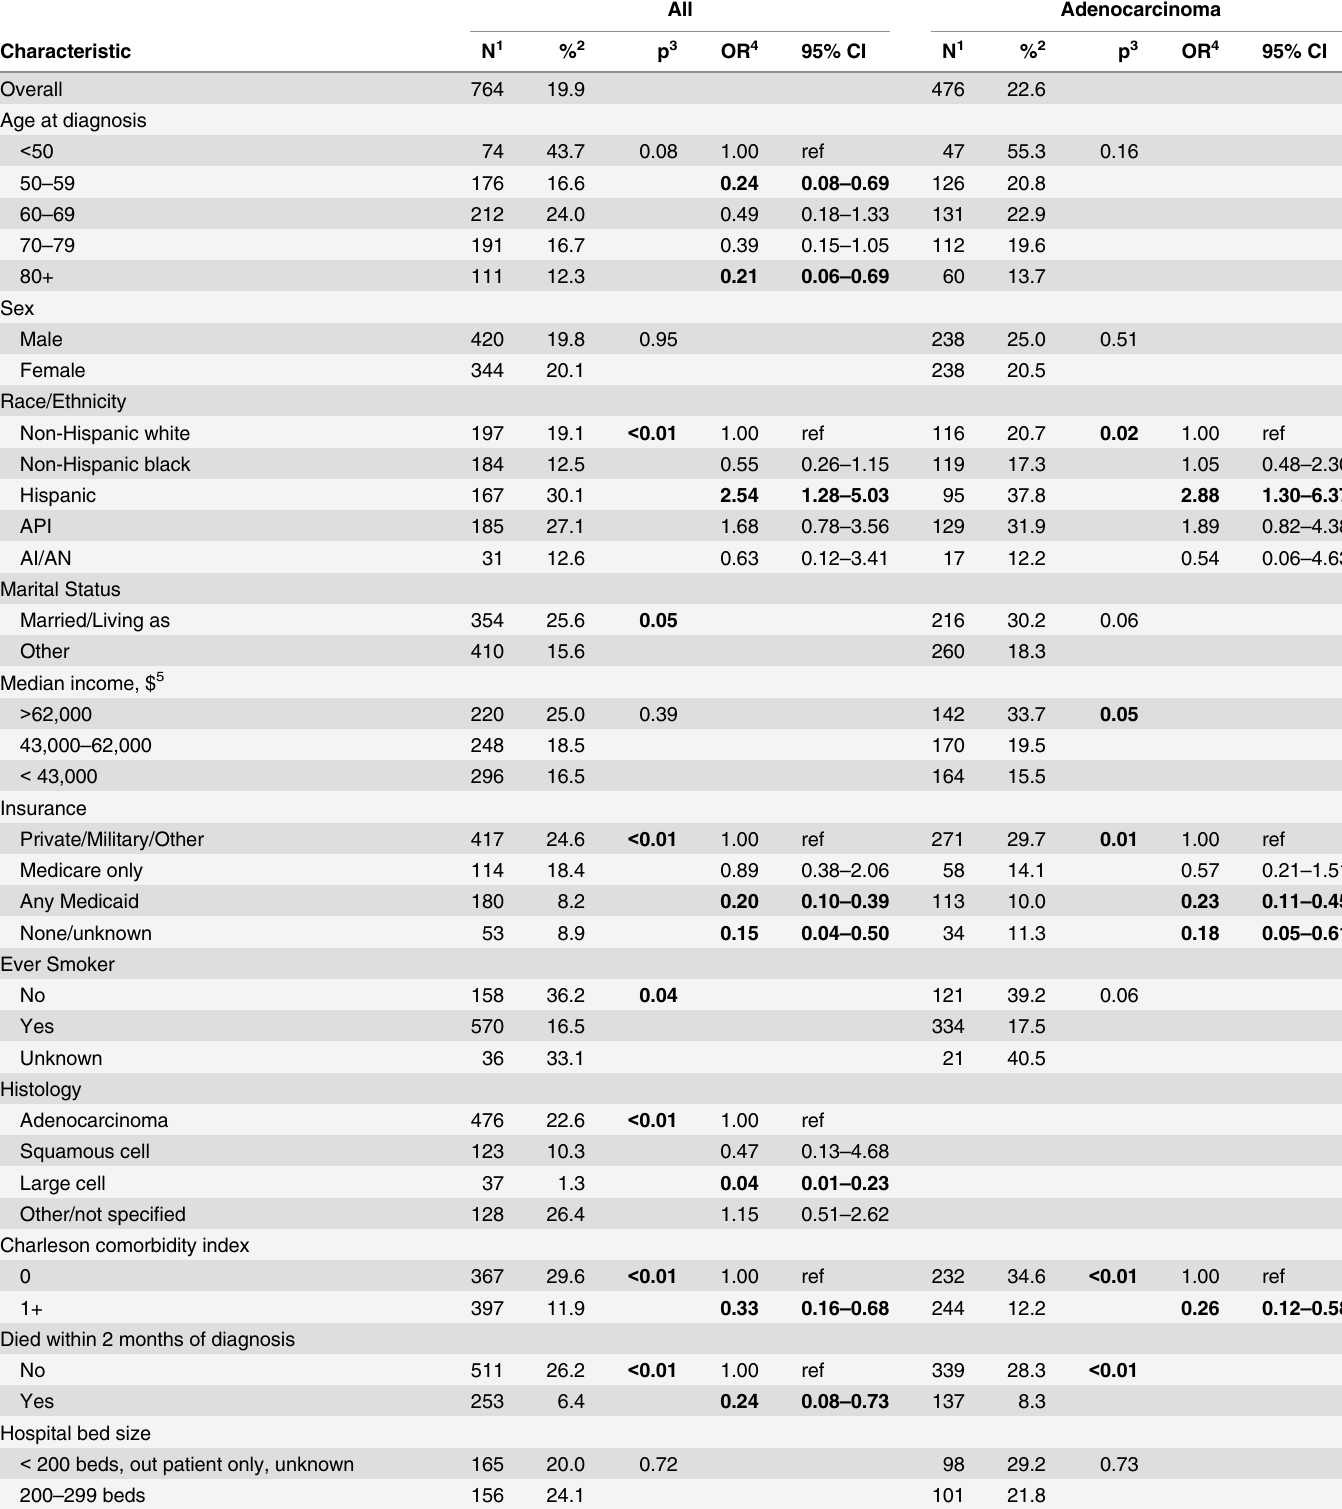
Table 3. Factors associated with EGFR testing among patients diagnosed in 2010 with stage IV non-small cell lung cancer, Patterns of Care. All